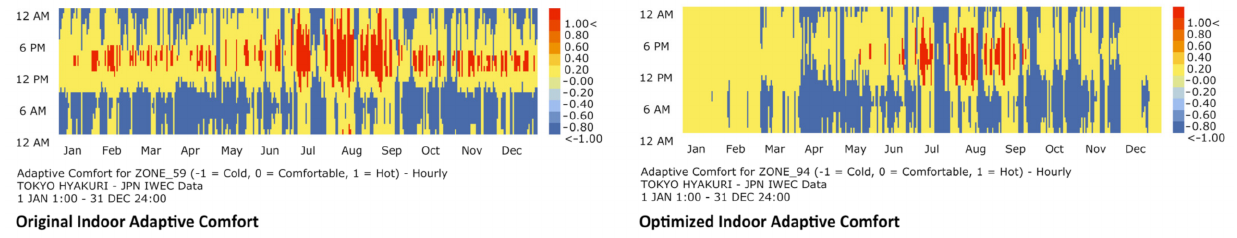
Figure 21. Adaptive comfort comparison of the original and the optimized